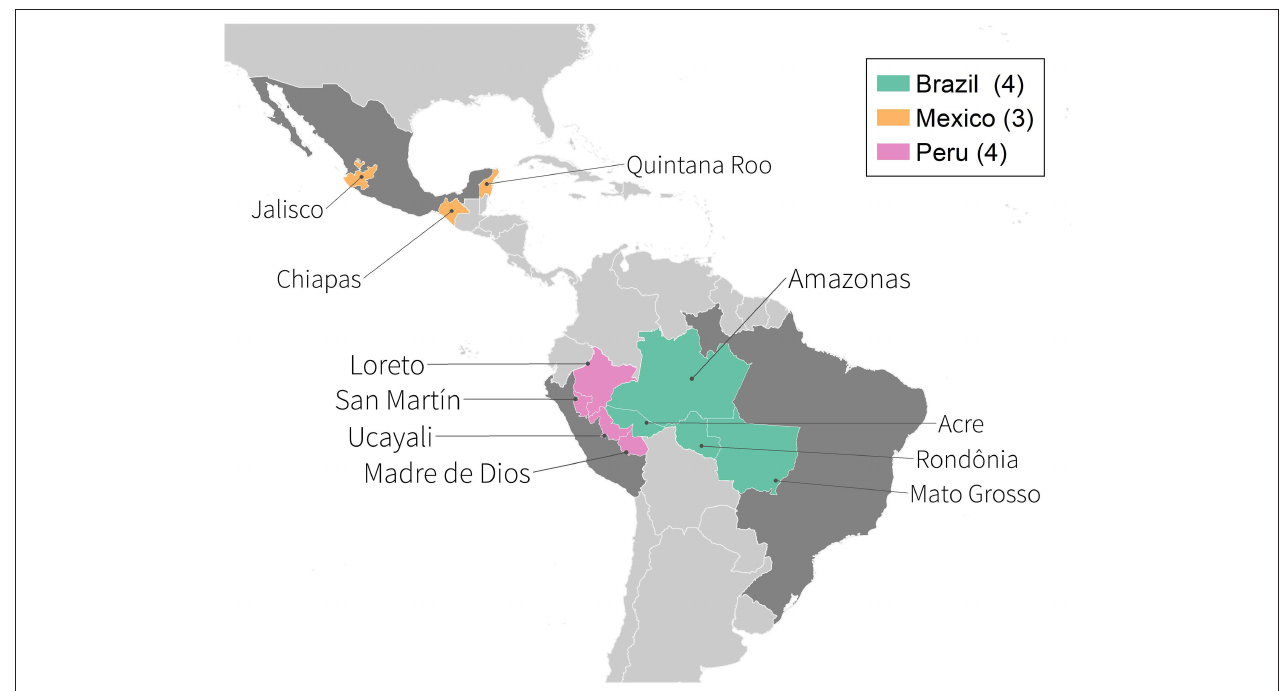
FIGURE 1 | Map showing the 11 tropical forest jurisdictions assessed for baseline conditions in implementation of the